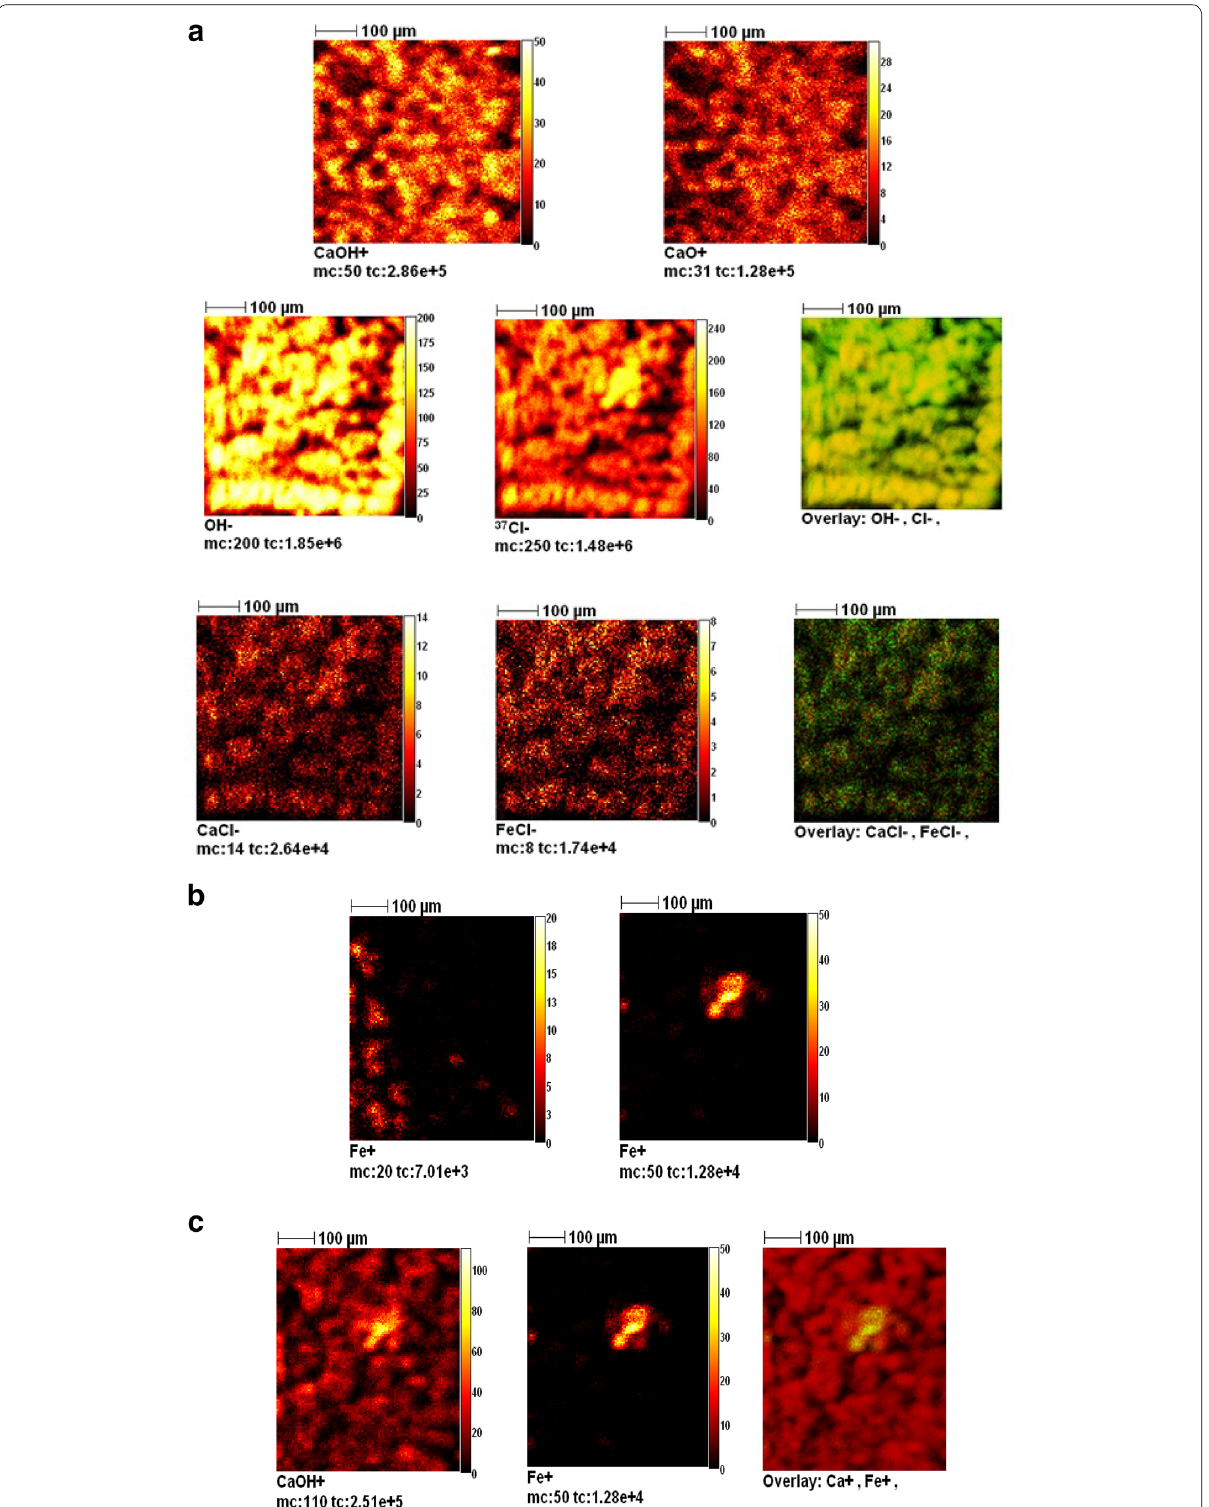
Fig. 1 SIMS-TOF mass spectral images for 2% Fe-loaded eggshell catalyst representing ( a ) distribution of Ca and Fe in different forms, ( b ) distribution of Fe clusters, and ( c ) relative distribution of Fe &